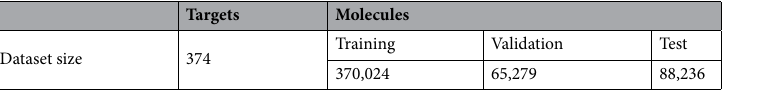
Table 4. Description of dataset size. The number of targets is 374 for all datasets. Training dataset has 370,024 molecules. Validation dataset has 65,278. Test dataset has